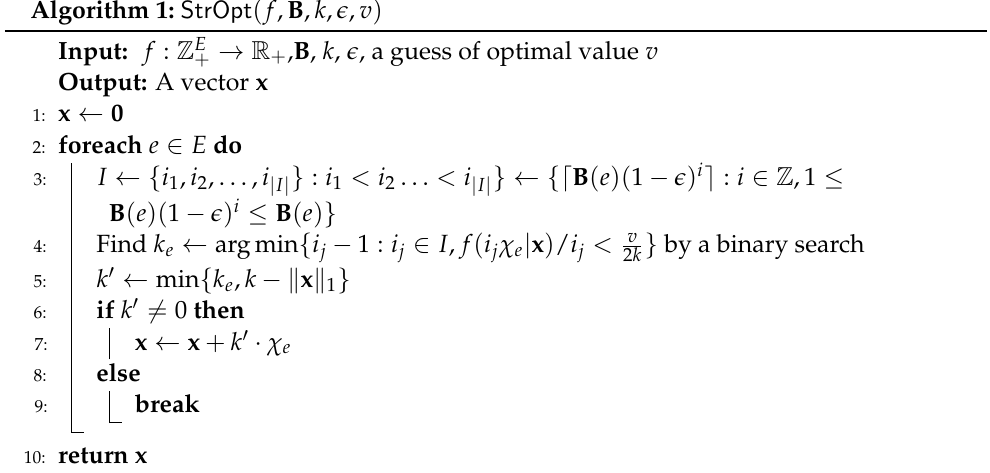
Algorithm 1: StrOpt ( f , B , k , (cid:101) , v